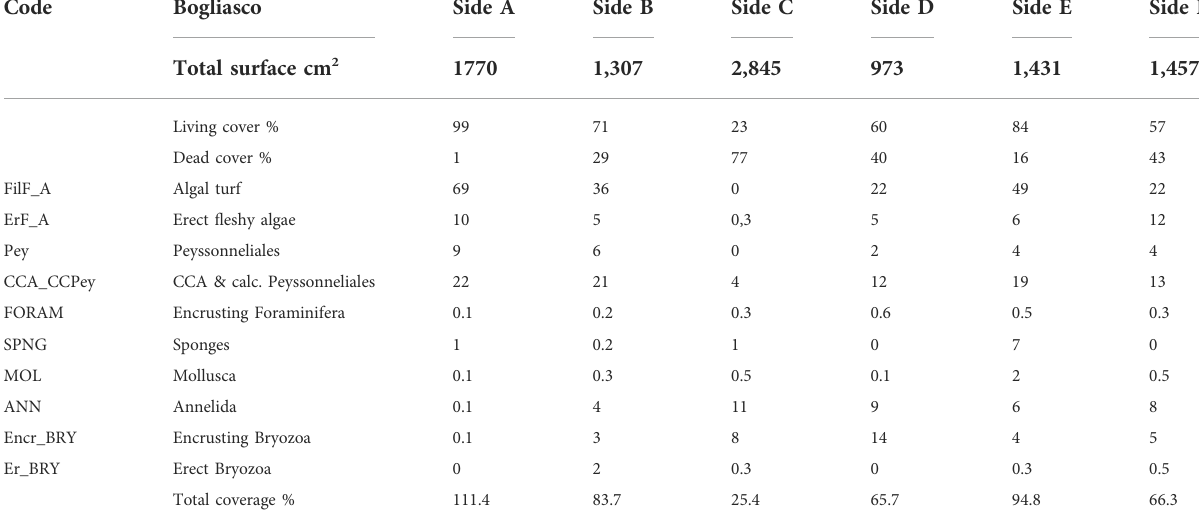
Coverage can exceed 100% due to superposition.